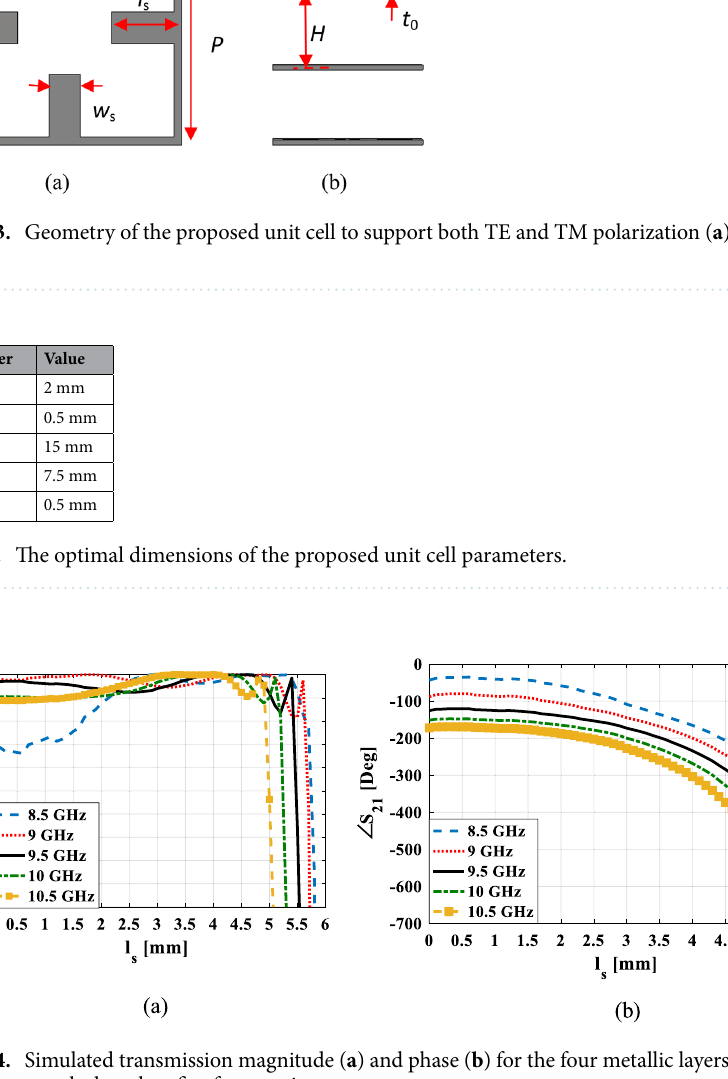
Figure 4. Simulated transmission magnitude ( a ) and phase ( b ) for the four metallic layers unit cell shown in Fig. 3 versus stubs length at five